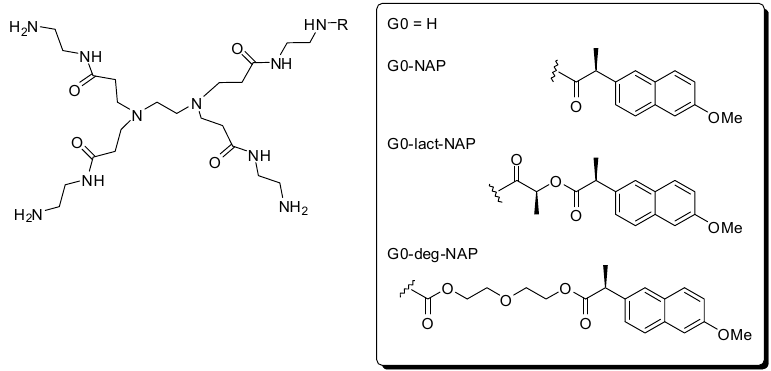
Figure 5. Dendrimer prodrugs useful for improving naproxen solubility and bioavailability [36].